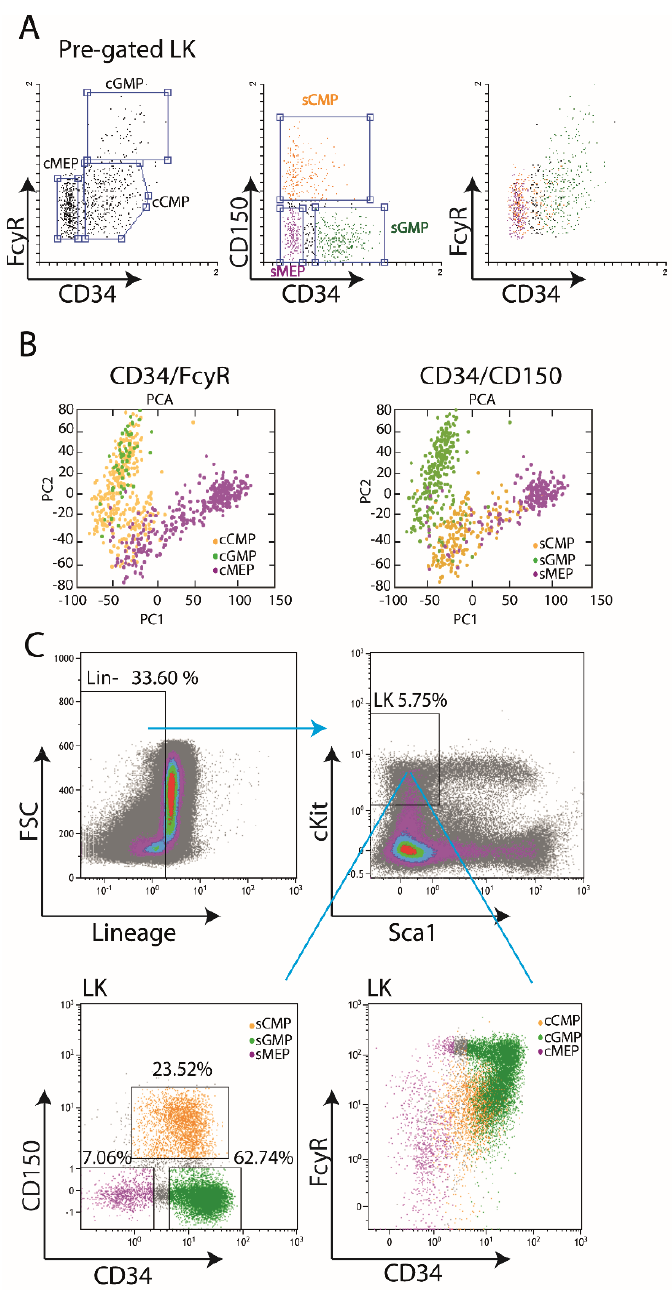
Figure 1. Surface expression of CD34/CD150 suggests better separation of the LK compartment compared to CD34/ Fc γ R. ( A ) Index-sort data from Nestorowa et al., was re-analyzed and visualized (see Materials and methods). LK compartment was dissected using the classical CD34/Fc γ R (left plot) or CD34/CD150 approach (center plot) . Right plot shows the CD34/CD150 sub-populations (sCMP Orange, sGMP Green, and sMEP Pink) on a CD34/Fc γ R plot. ( B ) Principal component analysis (PCA) score plot of 4282 variable genes within the myeloid progenitor LK compartment from Nestorowa et al., gated either by CD34/Fc γ R (left plot) or by CD34/CD150 (right plot). PCA plot of the single-cell data characterizes the trends exhibited by the expression profiles of CMPs (orange), GMPs (green), and MEPs (pink). Each dot represents a single cell, and each color represents the gated subpopulation based on CD34/Fc γ R (left) or CD34/CD150 (right). Numbers of cells within each population were as follows: cCMP: 332, cGMP: 55, cMEP: 339, sCMP: 200, sGMP: 278 and sMEP: 211. ( C ) Fresh BM mononuclear cells shown with the dissection of LK cells either by CD34/CD150 (left), or by CD34/Fc γ R (right), colors as above.